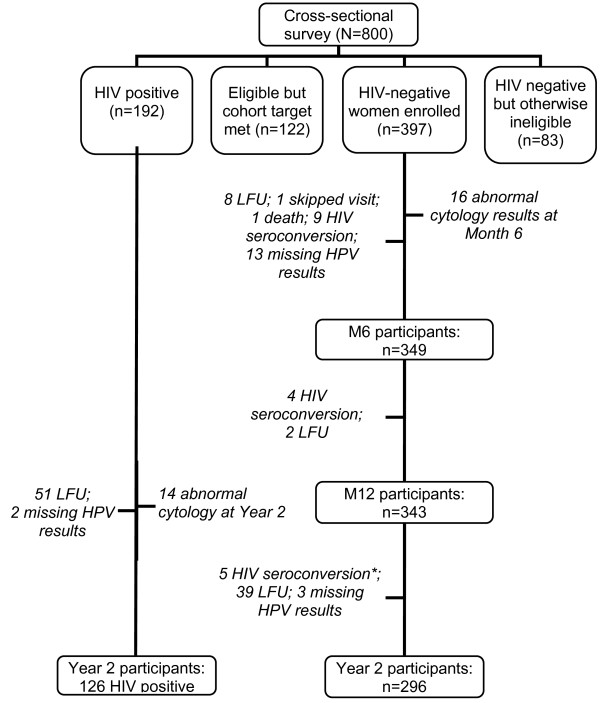
Flow diagram - HPV analysis data set (cytologically normal women). Footnote: Abbreviations: HIV = human immunodeficiency virus; HPV = human papillomavirus; LFU = lost to follow-up *in total there were 6 HIV seroconversion between M12 and Year 2, but one participant was already dropped from HPV data analysis set because of abnormal cytology results at M6. HPV genotyping and cervical cytology was performed among HIV-negative women at Month 6 and Year 2 and among HIV-positive women at Year 2 only. Women with abnormal cytology results are excluded from the HPV analysis dataset.